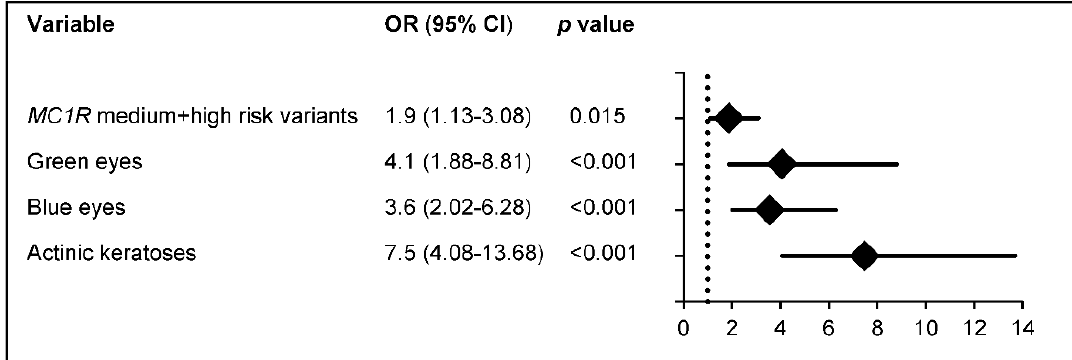
13 of 20 Figure 4. Distribution of MC1R risk groups in different cases/controls scenarios: ( A ) correlated with skin aging scores; significant p values ( p < 0.05) calculated by Chi-square test are displayed in bold; n.a.: not available, ISA: intrinsic skin aging, ESA: extrinsic skin aging, TSA: total skin aging; ( B ) in